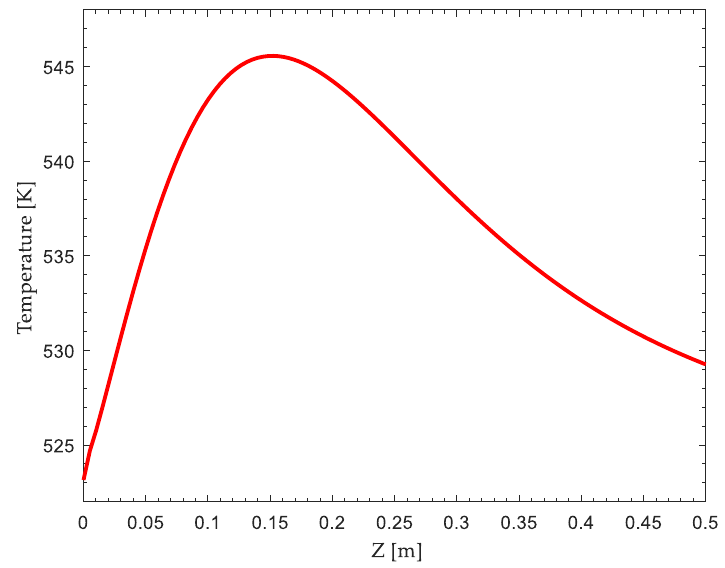
Figure 14. Axial CO 2 mass fraction profile at representative tube centerline (0.5-m reactor module) under 7-m 3 /h thermal oil feed rate.